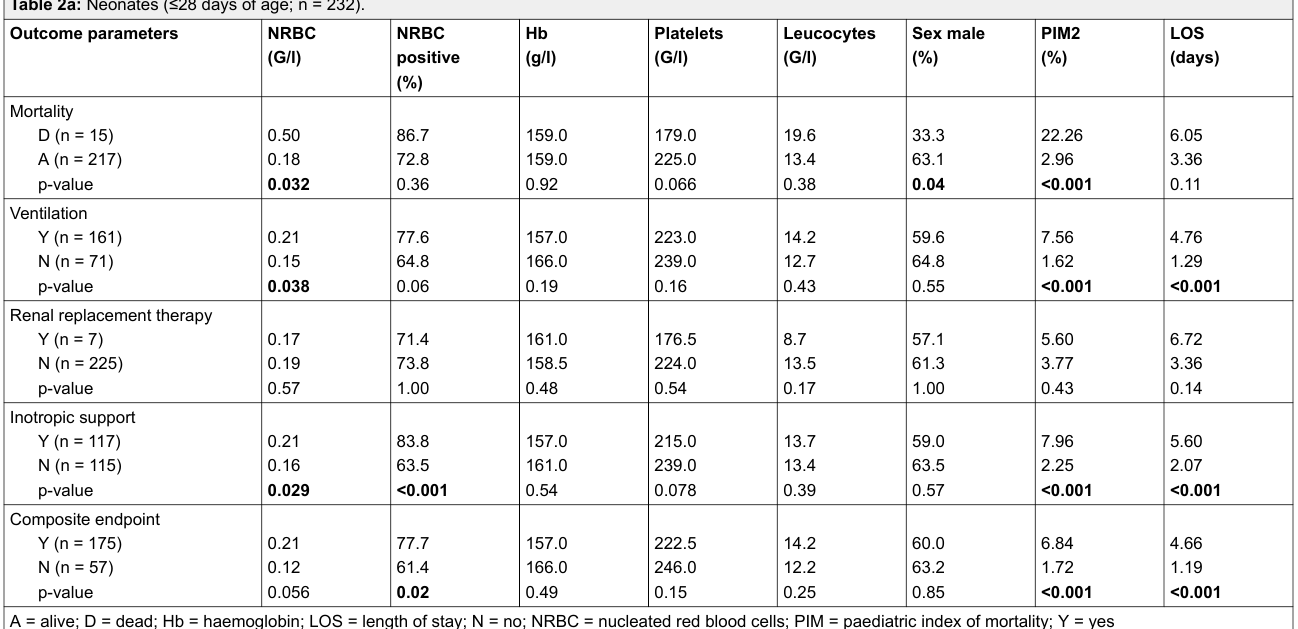
Table 2b: Children (>28 days of age; n = 438). Outcome parameters